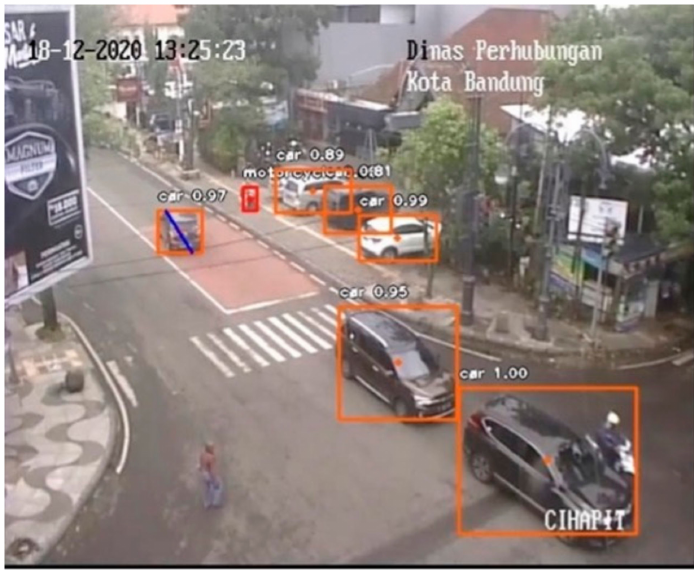
Figure 5. Detection result on the frame of CCTV stream.